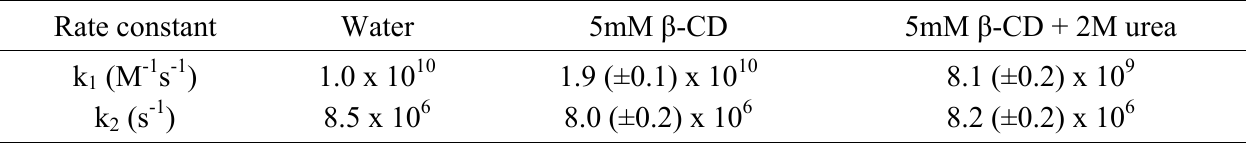
Table 7. Rate constants for the ESPT reaction of CAZL in the presence of different